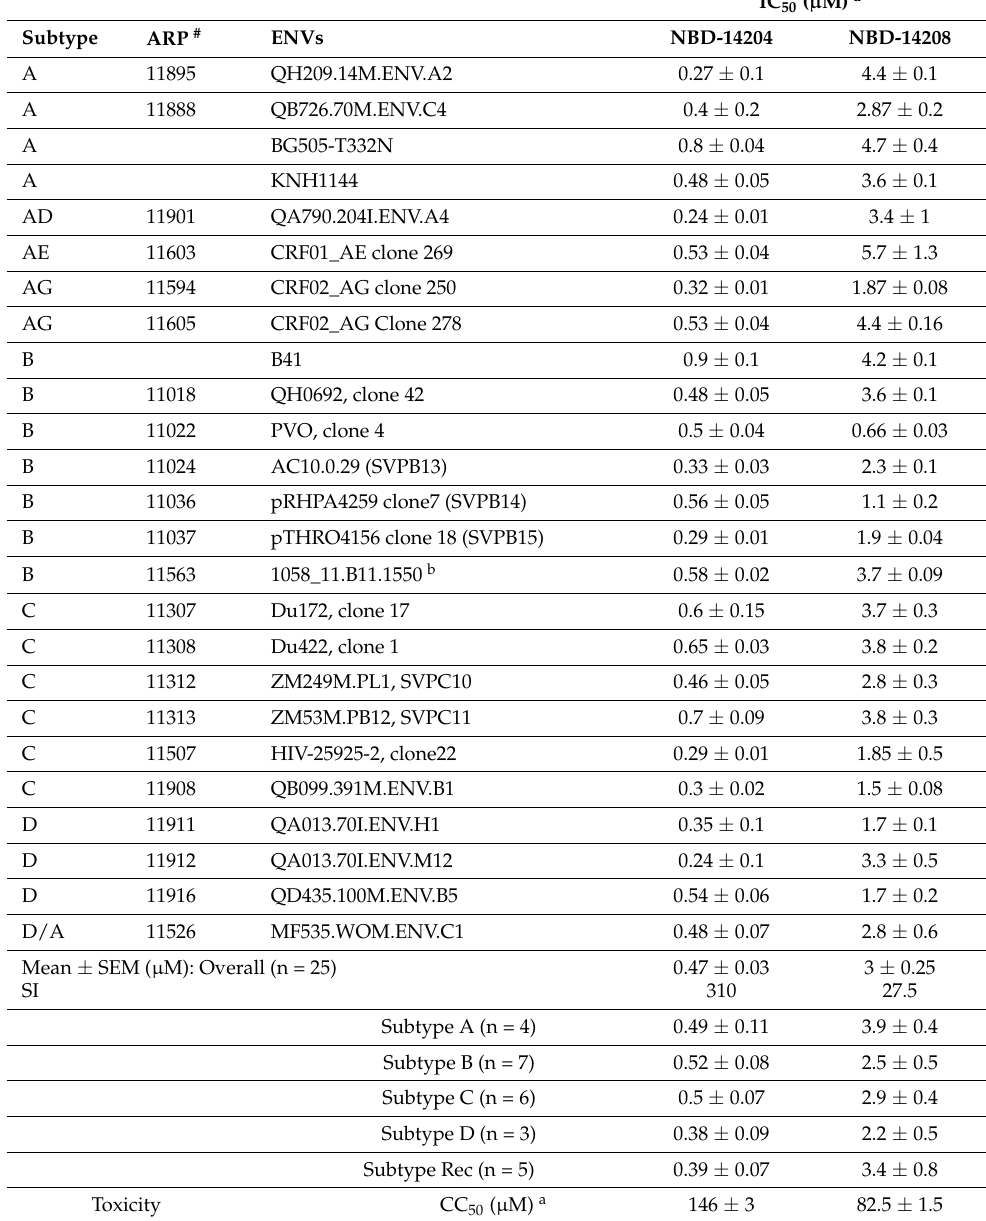
Table 1. Neutralization Activity of NBD Compounds against a selection of Env-pseudotyped HIV-1 clinical